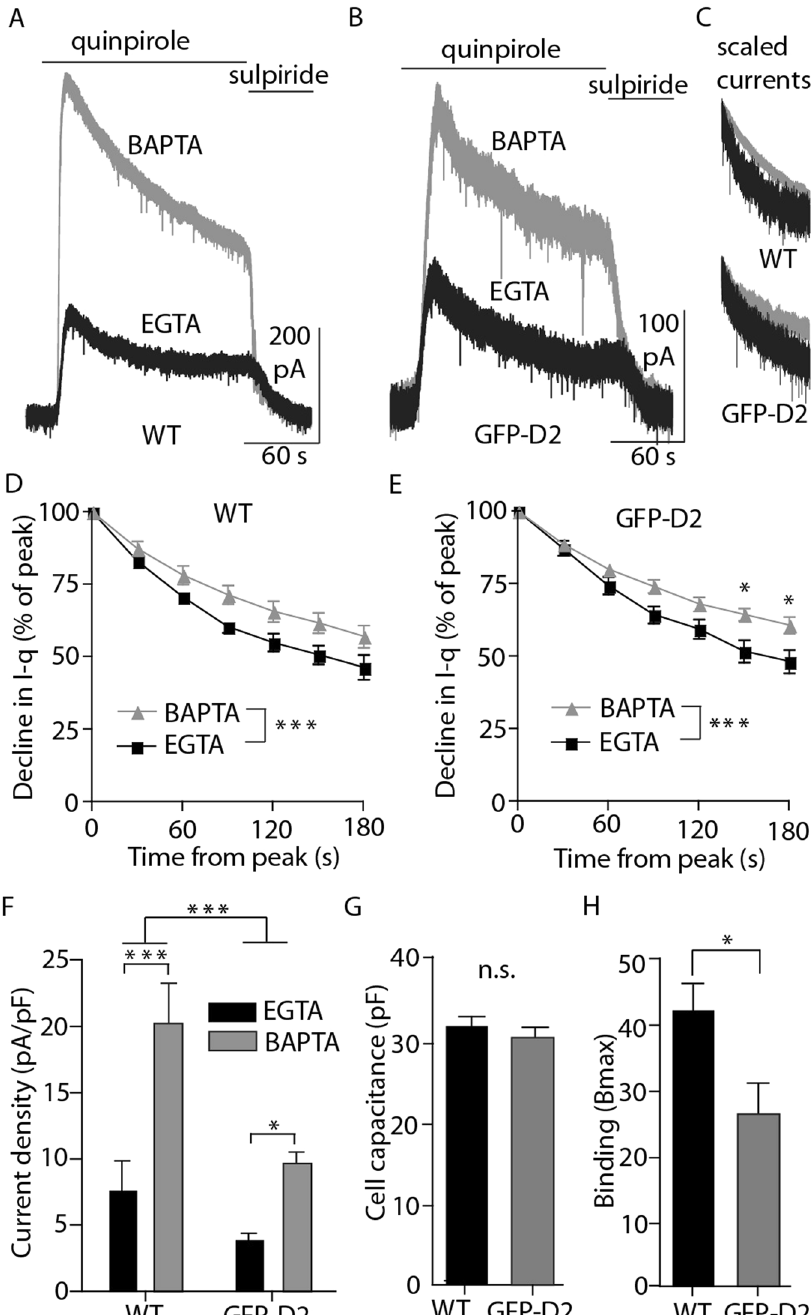
Figure 2. Knocked-in D2 receptor functions in dopamine neurons, but is expressed at levels below the wild type. ( A,B ) Representative whole-cell voltage clamp recordings of dopamine neurons from wild type and GFP- D2 acute slices during the bath application of the D2 agonist quinpirole (10 µ M) followed by the antagonist sulpiride (600 nM). ( C ) Example BAPTA and EGTA currents from wild type (top) and GFP-D2 (bottom) scaled and peak aligned. ( D ) In wild type, the quinpirole-induced current declines significantly more from peak value when EGTA internal is used compared to BAPTA (n = 5 and 7, two-way ANOVA followed by Bonferroni). ( E ) In the GFP-D2, the quinpirole-induced current also declines significantly more from peak value when EGTA internal is used compared to BAPTA (n = 7 and 10, two-way ANOVA followed by Bonferroni). ( F ) In both wild type and GFP-D2, the quinpirole-induced current density was larger using BAPTA internal compared with EGTA internal. As a group, wild type current density was larger than that for GFP-D2 (n = 5–10, two-way ANOVA followed by Bonferroni). ( G ) The average cell capacitance did not differ between the wild type and GFP-D2 groups (n = 21 and 29, unpaired t test). ( H ) The density of D2 receptors from midbrain samples as measured by the binding of [ 3 H]YM-09151-2, was significantly greater in wild type compared to GFP-D2 (n = 9 each, unpaired t test). * p < 0.05, *** p <